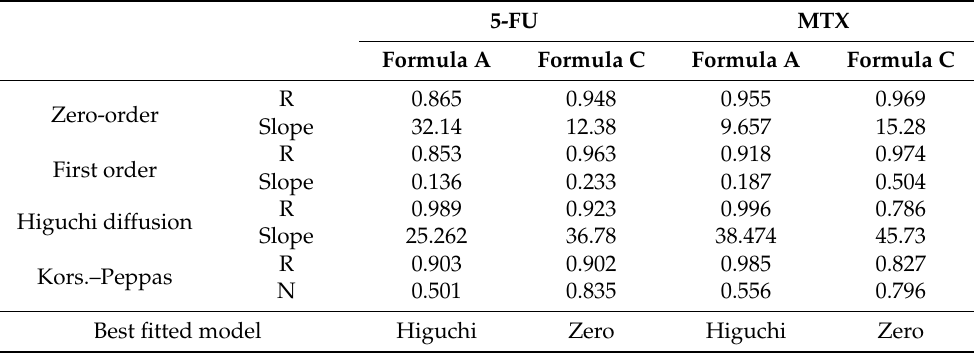
Table 3. The kinetic models of the in vitro release